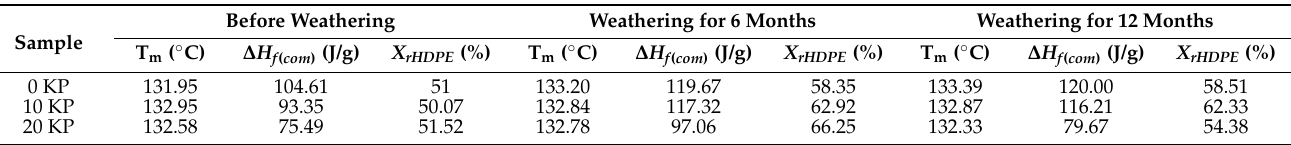
Table 3. DSC outputs of KP-filled rHDPE/NR blends before and after 6 and 12 months of natural weathering.